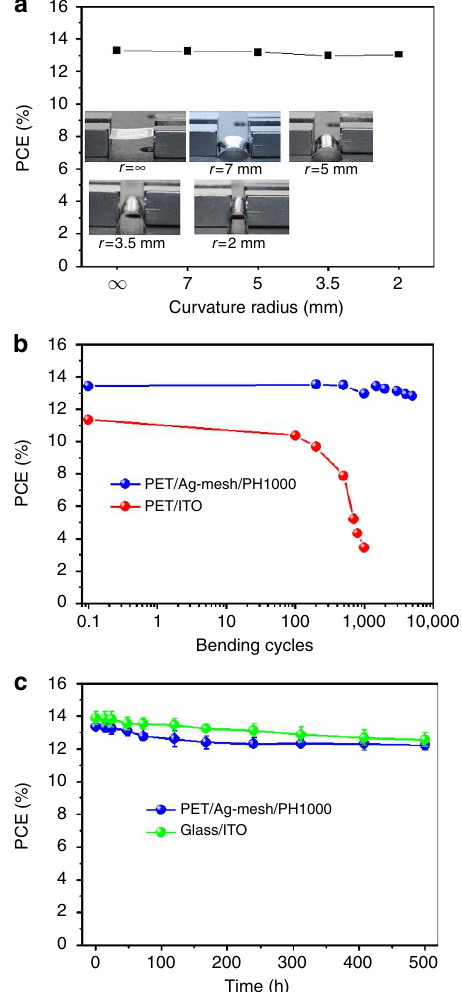
Figure 6 | Bending and stability test of flexible pero-SCs. ( a ) PCEs measured after bending PET/Ag-mesh/PH1000 electrode-based flexible pero-SCs within a specified radius of N , 7, 5, 3.5 and 2mm. The inset shows the real images of the corresponding bending radii, respectively. ( b ) PCEs of flexible pero-SCs based on both PET/Ag-mesh/PH1000 and PET/ITO electrodes as a function of bending cycles at a radius of 5mm. ( c ) Stability of pero-SCs based on both PET/Ag-mesh/PH1000 and glass/ITO substrates under room temperature in N 2 -filled glove box in a timescale of a few hundred hours. PCE values are obtained from statistical distribution of six devices for each condition. The ball symbols represent the mean, while the line across the ball represents the